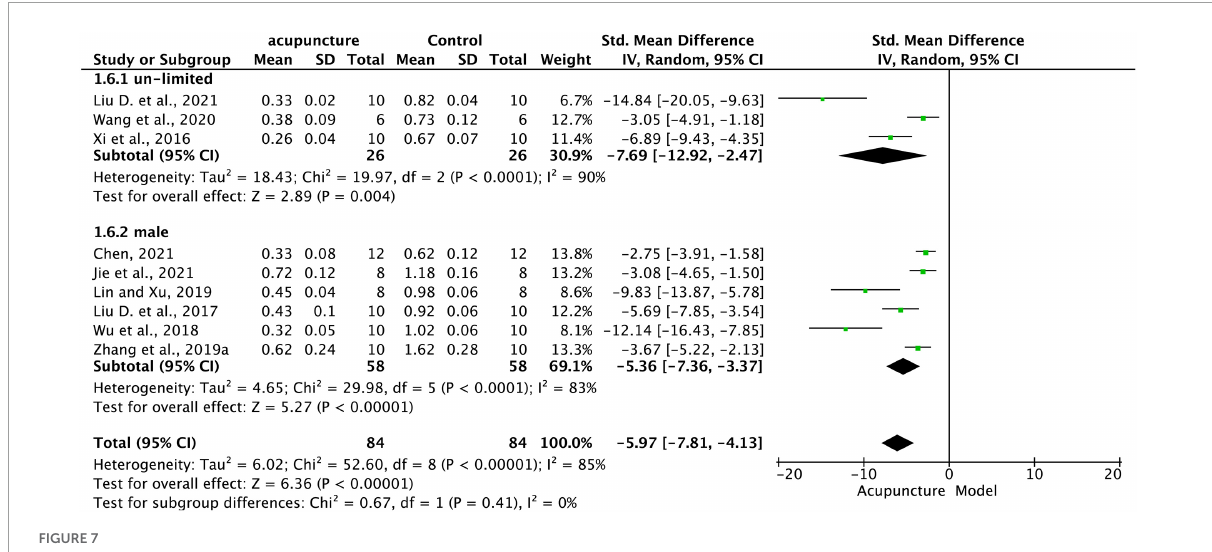
modulated the mRNA and protein expression levels of Bcl- 2, Bax, Caspase-9, and Caspase-3, inhibited the expression of Cyt-c, and reduced the chondrocyte apoptosis rate, suggesting that acupuncture achieved this by inhibiting the activation of mitochondrial